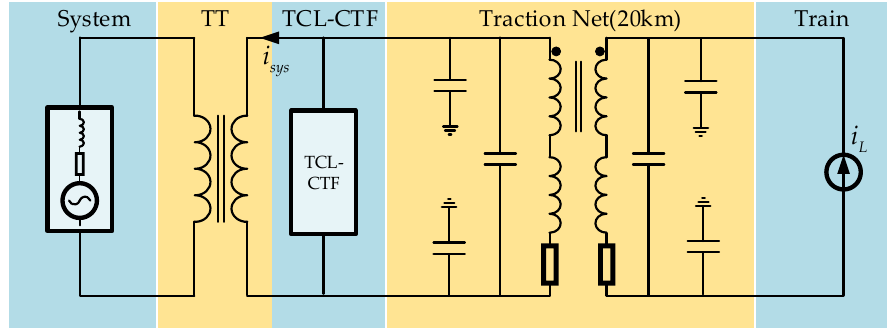
Figure 11. Diagram of filtering characteristic simulation.